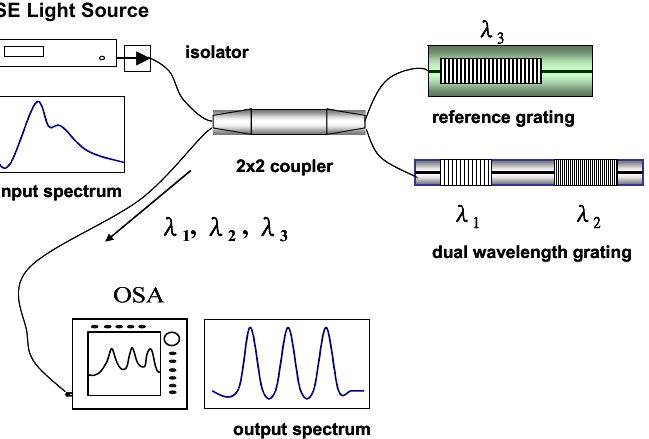
Figure 1. A reference dual wavelength grating system.